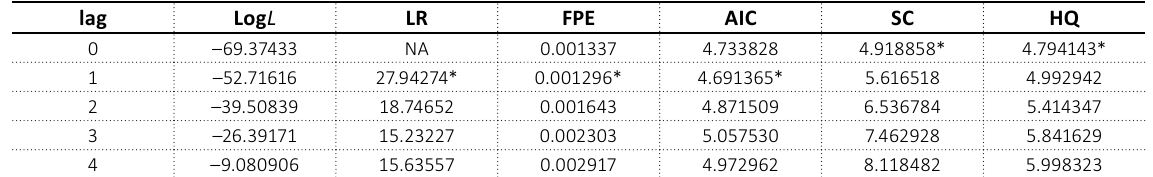
Table 2. Optimal lag test results